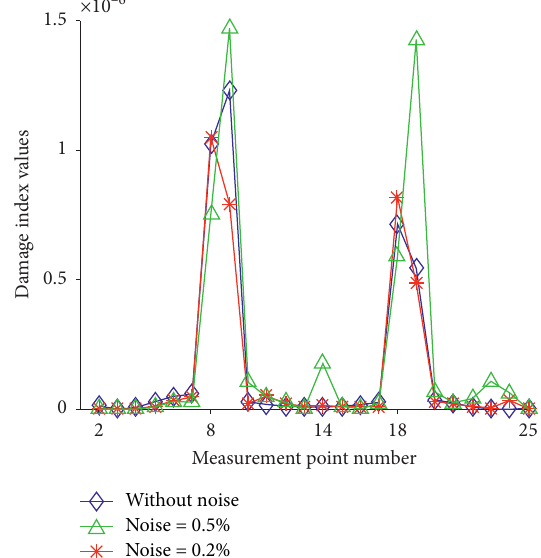
Figure 12: DI values of a cantilever beam with double damage.